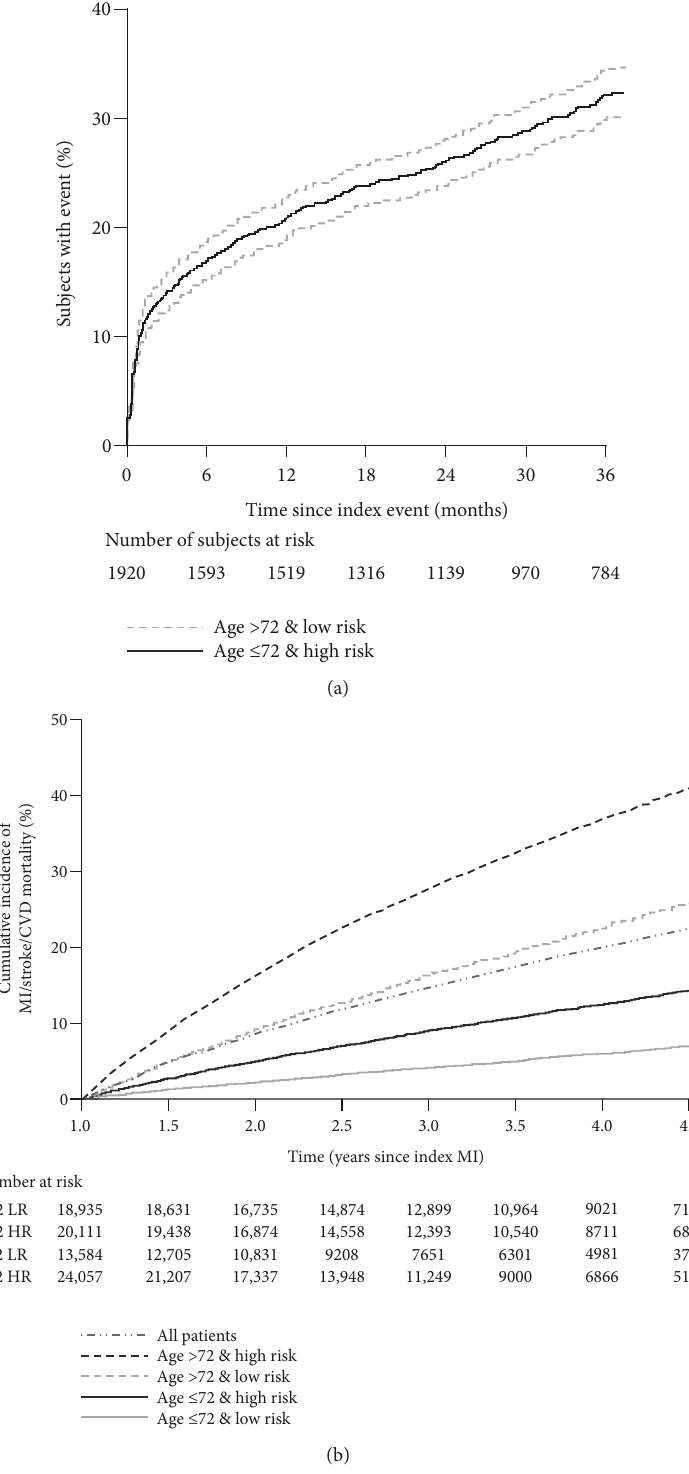
Figure 2: The persistent risk of MACE (a) up to 3 years following an index MI (adapted from Blin et al ., 2016) [3] and (b) up to 4.5 years following an index MI stratified by age ( < 72 years old versus ≥ 72 years old) and risk category (low versus high a ) (adapted from Jernberg et al. , 2015) [4]. a High-risk patients were predefined as those with ≥ 1 of the following risk factors prior to index; MI: diabetes mellitus, at least one MI prior to index MI event, CABG (proxy for multi-vessel CAD), PAD, stroke, heart failure, or diagnosis of chronic renal dysfunction. CABG, coronary artery bypass graft; CAD, coronary artery disease; CV, cardiovascular; HR, high risk; LR, low risk; MACE, major adverse cardiovascular events; MI, myocardial infarction; PAD, peripheral artery